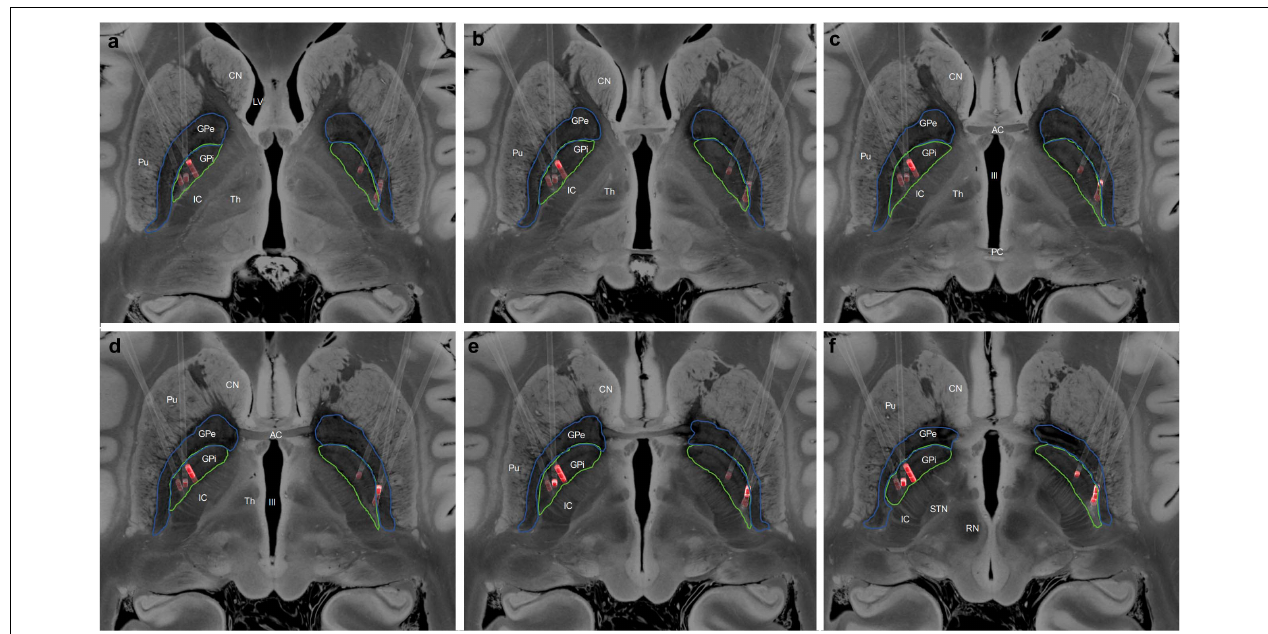
FIGURE 1 | (a–f) Localization of the deep brain stimulation (DBS) electrodes, in standard space, for all patients. The Globus pallidus internus (GPi, green) and Globus pallidus externus (GPe, blue) have been manually segmented, and the active electrode contacts highlighted in red. CN, Caudate Nucleus; LV, Lateral Ventricle; Pu, Putamen; IC, Internal Capsule; Th, Thalamus; AC, Anterior Commissure; PC, Posterior Commissure; III, Third Ventricle; STN, Subthalamic Nucleus; and RN, Red